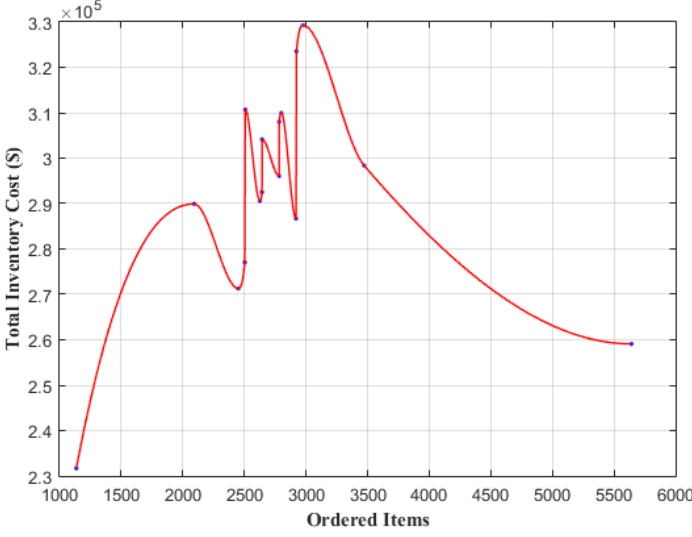
Figure 13. Total inventory cost vs. ordered items .